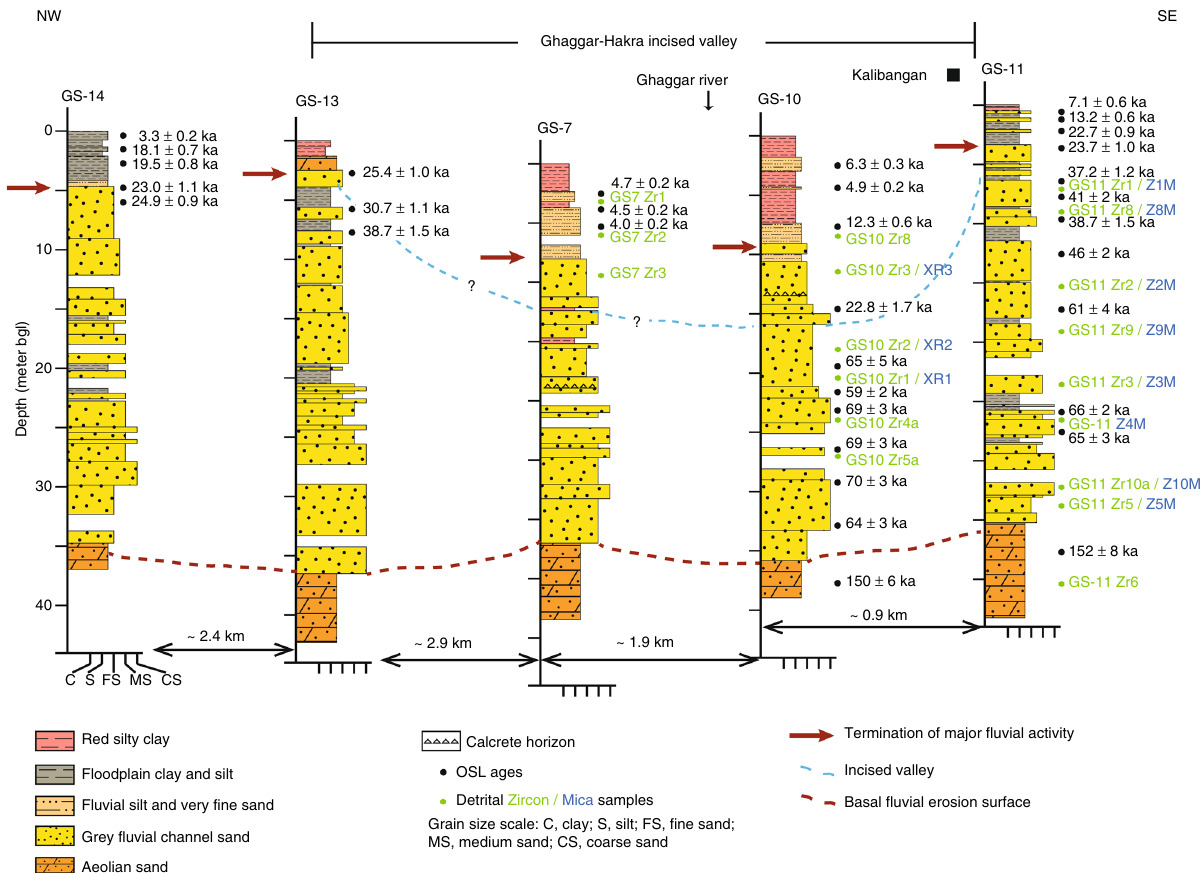
Fig. 5 Stratigraphic panel showing core stratigraphy, sedimentology and K-feldspar OSL ages at GS core sites along transect across Ghaggar – Hakra palaeochannel near to Indus urban centre of Kalibangan. Note how in cores GS7 and GS10, sediments show young OSL ages that are inset into surrounding older strata, indicating that the sediments with young ages in fi ll an incised valley. Additional evidence for this comes from the abrupt age disjunction observed in core GS10 at ~ 16 m depth, which de fi nes the base of the incised valley. Sampling points for U-Pb detrital zircon and 40 Ar/ 39 Ar detrital muscovite analysis are also indicated. Stratigraphic sections are arranged in elevation. Dashed lines indicate basal fl uvial erosion surface (red) and base of youngest incised valley (blue). Note variable horizontal scale. bgl below ground